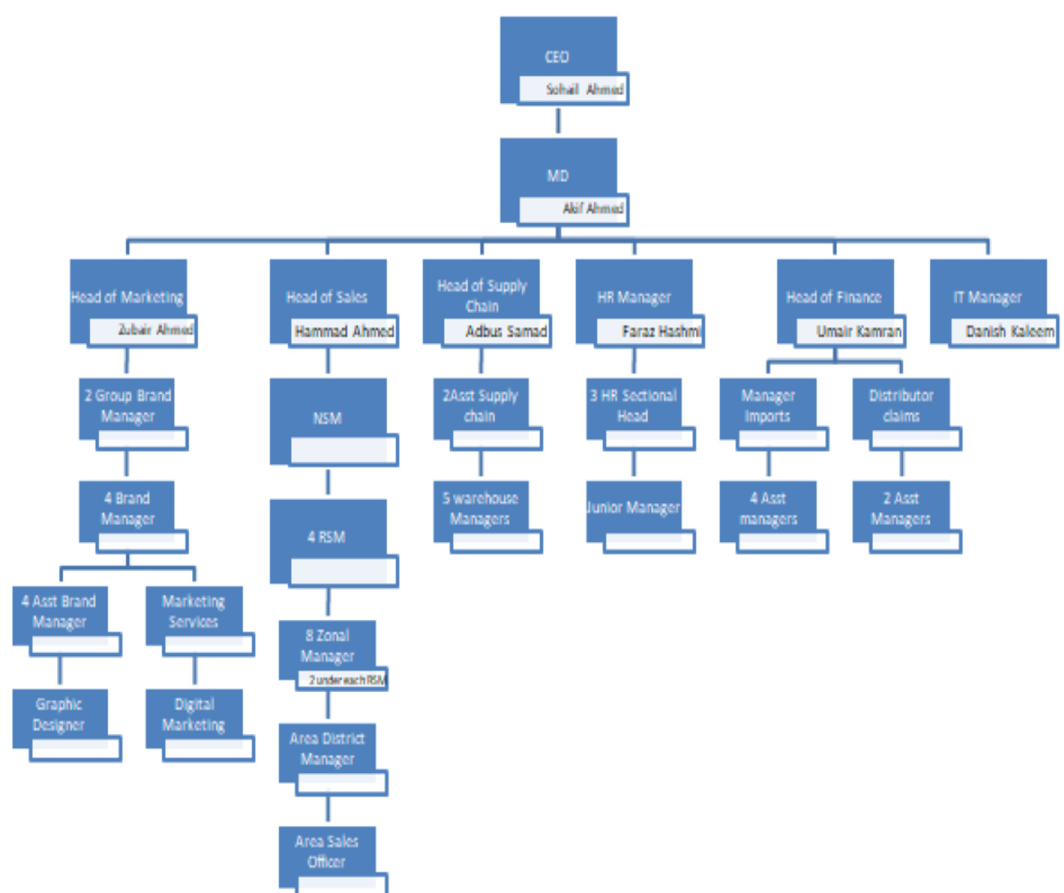
Figure 2: Organizational Chart of Bays International; Source: Bays International (2019) Sales trends and market